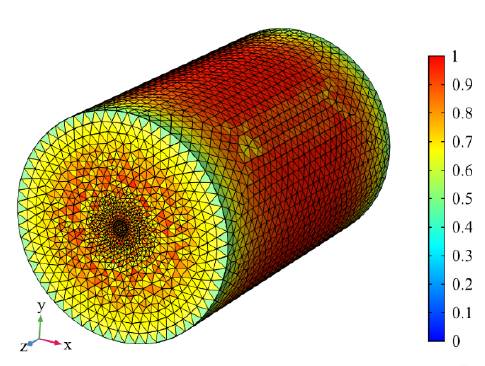
Figure 4. Physical model and mesh division.